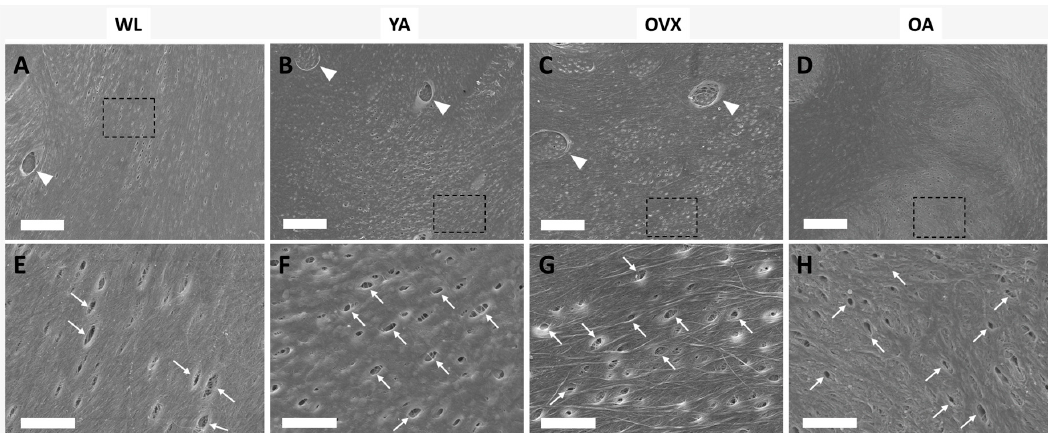
Figure 2. Scanning electron microscopy (SEM) images of the endocortical surface of the femoral bone in the four models ( A , E , weanlings (WL); B , F , (young adults) YA; C , G , osteoporosis model (OVX); D , H , (old adults) OA). The bottom images are enlargements of the dashed boxes in the upper images, respectively. Triangles indicate the traces of osteocytes, and arrows indicate the canaliculi holes. ( A – D ) Scale bar: 20 µm. ( E – H ) Scale bar: 5 µm.